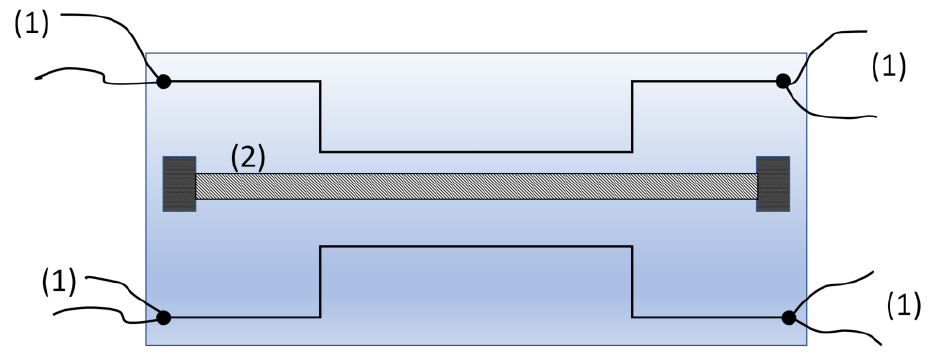
Figure 12. Sensor of the pulse hot strip method: the strip (2) is located at the center, and the tem- perature sensors ((1) wires working as four-wire resistance thermometers) are at different distances from it.